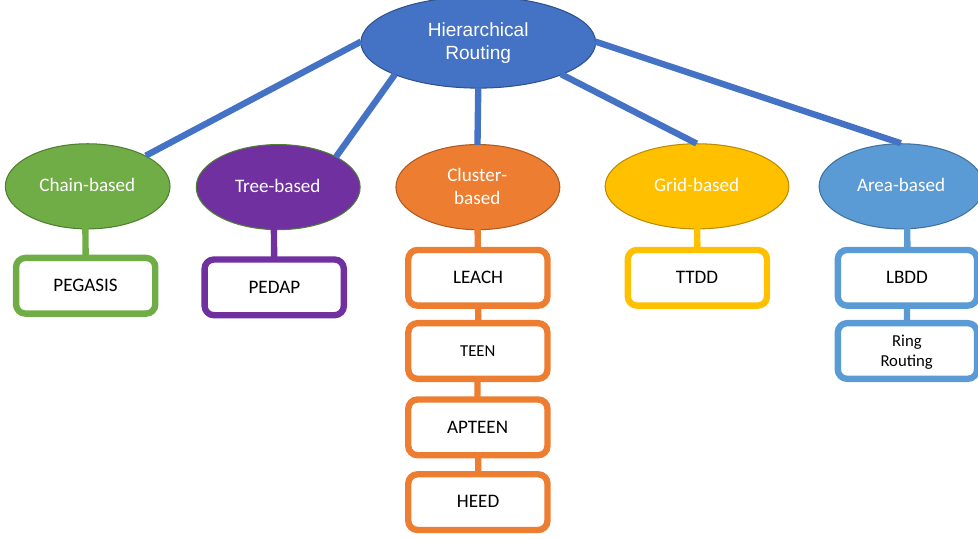
Figure 4. Classification of hierarchical routing